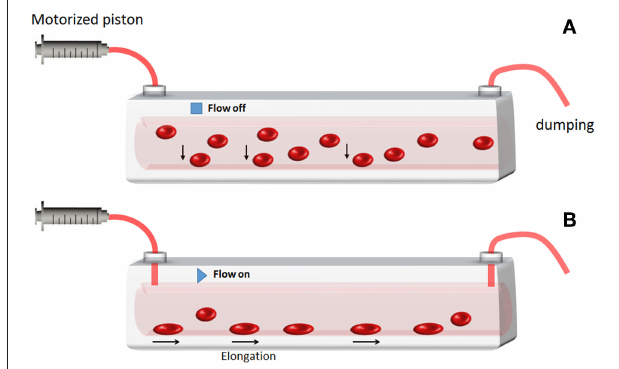
FIGURE 1 | Sketch of the RBC deformation under hydrodynamic pressure. (A) Some RBCs injected in the channel fall under gravity at the bottom. (B) After 10min time, RBCs are deposited and attached on the bottom of the channel. Then, by enhancing the flow speed/pressure the RBCs that were anchored at the bottom undergo membrane